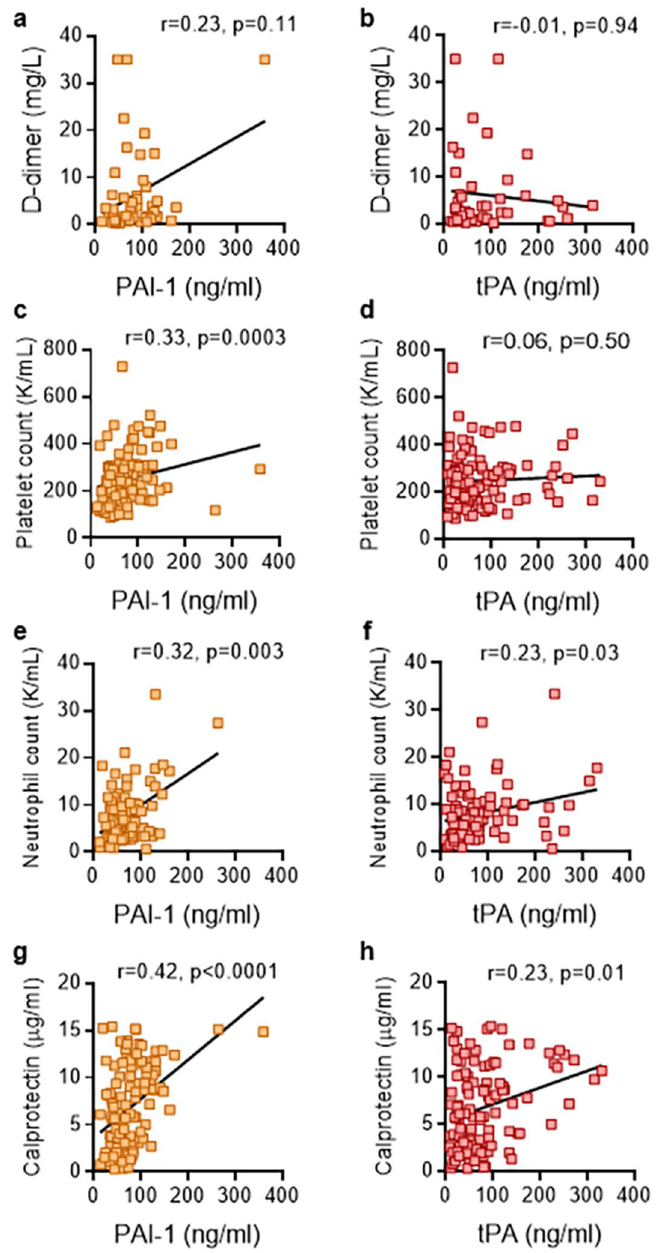
Figure 2. Association between PAI-1 and tPA and clinical biomarkers in plasma. Levels of PAI-1 and tPA were compared to D-dimer ( a , b ), platelet counts ( c , d ), absolute neutrophil counts ( e , f ), and calprotectin ( g , h ). Spearman’s correlation coefficients were calculated. Statistics were calculated and the figure was produced in GraphPad Prism https ://www.graph pad.com/scien tific -softw are/prism /, using version